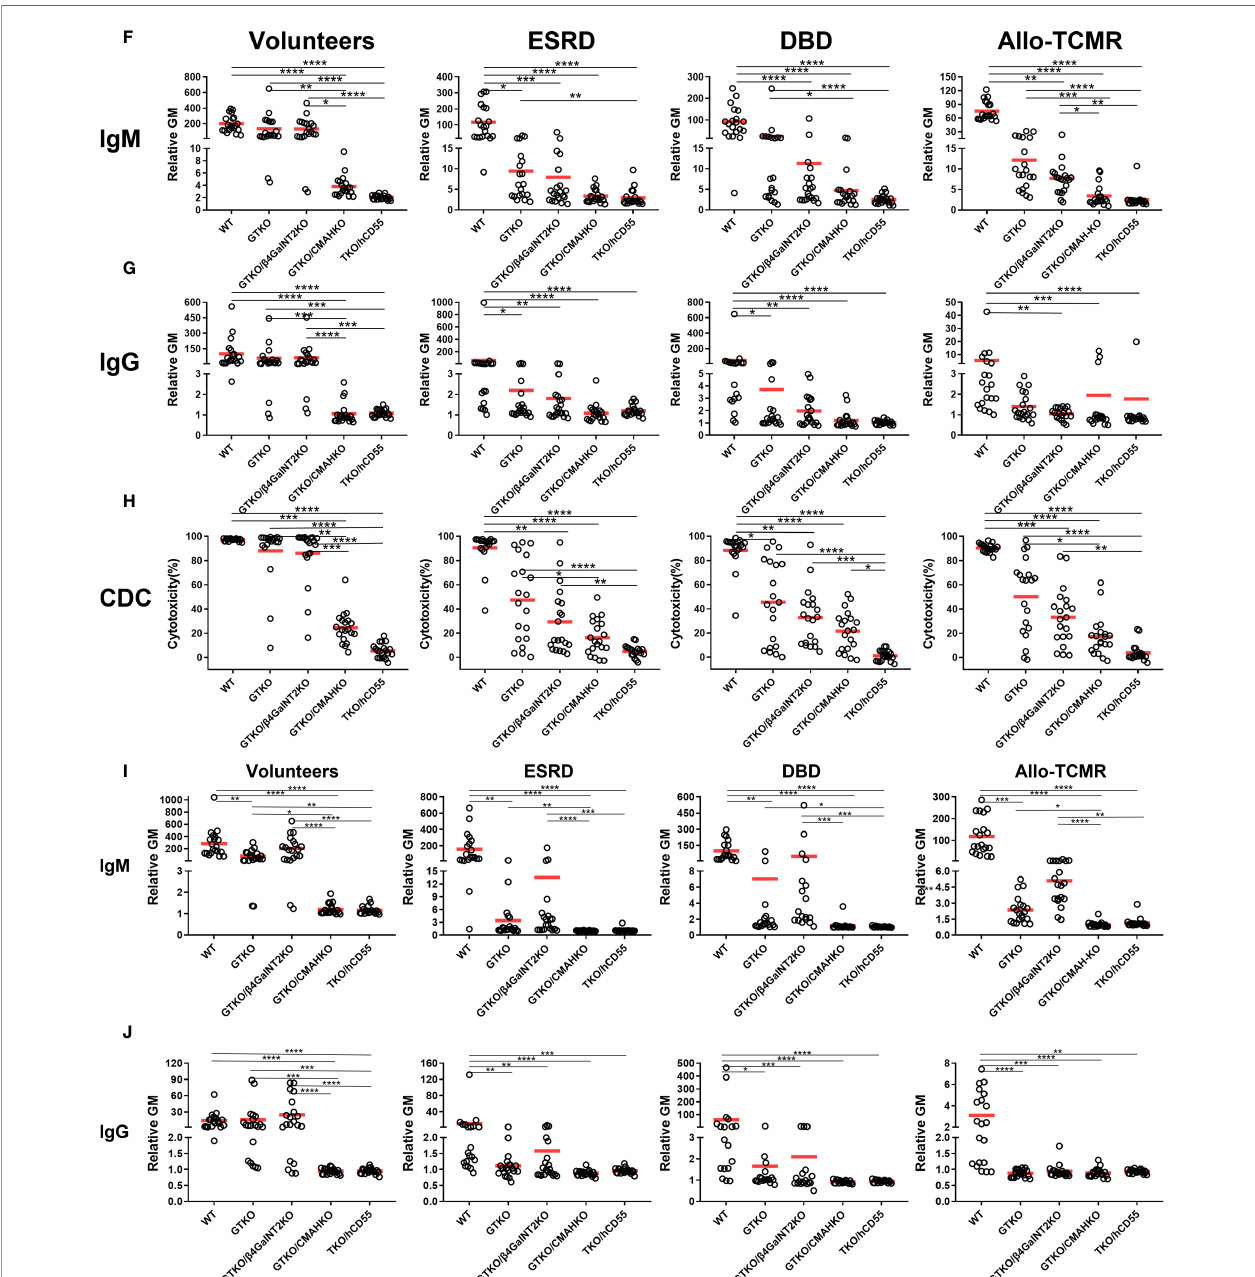
FIGURE 2 | Effect of different human sera on IgM and IgG binding and CDC to various pig PBMCs and RBCs and effect of genetic-engineering of pig PBMCs and RBCs on human IgM and IgG binding and CDC by fl ow cytometry. Comparison of mean (A) IgM/ (B) IgG binding and (C) CDC of sera from Volunteers, ESRD, DBD and Allo-TCMR to WT, GTKO, GTKO/ b 4GalNT2KO, GTKO/CMAHKO, and TKO/hCD55 pig PBMCs. Mean of (D) IgM and (E) IgG comparing binding of sera from Volunteers, ESRD, DBD, and Allo-TCMR to WT, GTKO, GTKO/ b 4GalNT2KO, GTKO/CMAHKO, and TKO/hCD55 pig RBCs. (*p <0.05, **p<0.01, ***p<0.005, ****p<0.001). Volunteers had very low levels of IgM/IgG binding and CDC to GTKO/CMAHKO and TKO/hCD55 pig PBMCs (F-H) or RBCs (I, J) . IgM and IgG binding and CDC to GTKO, GTKO/ b 4GalNT2KO, GTKO/CMAHKO, and TKO/hCD55 PBMCs (F – H) or RBCs (I, J) were low in sera from ESRD, DBD, and Allo- TCMR. (*p<0.05, **p<0.01, ***p<0.005,